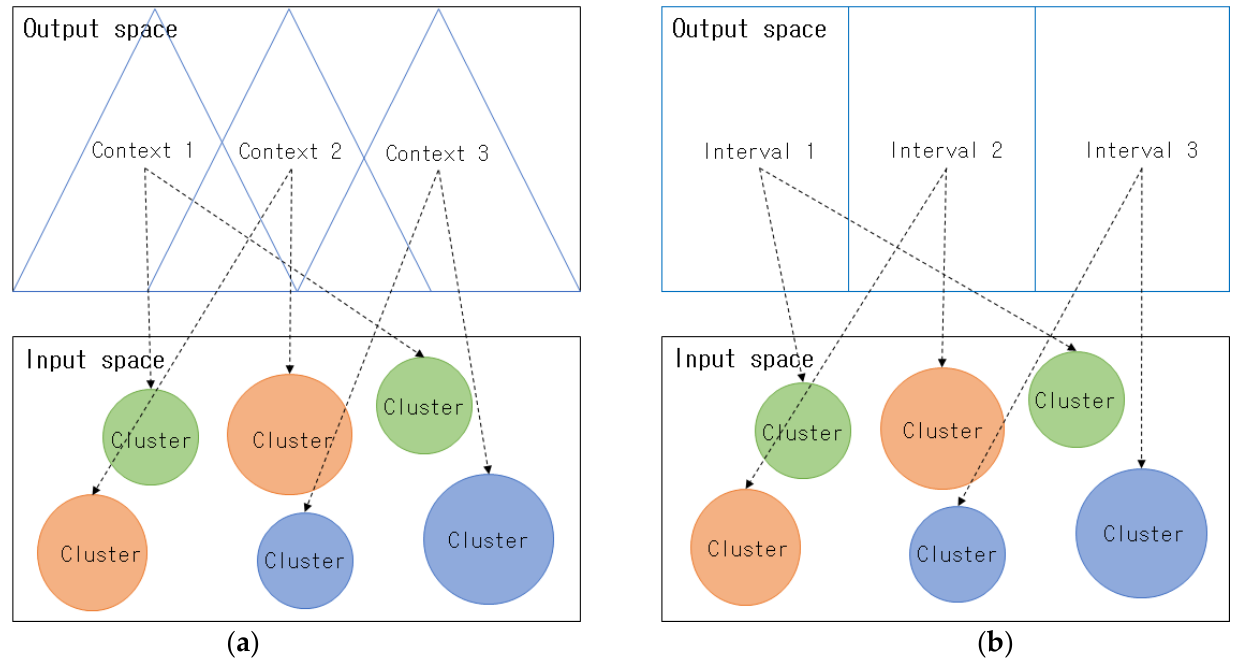
Figure 1. Context-based fuzzy clustering and interval-based fuzzy clustering concept: ( a ) context- based fuzzy clustering; ( b ) interval-based fuzzy clustering.